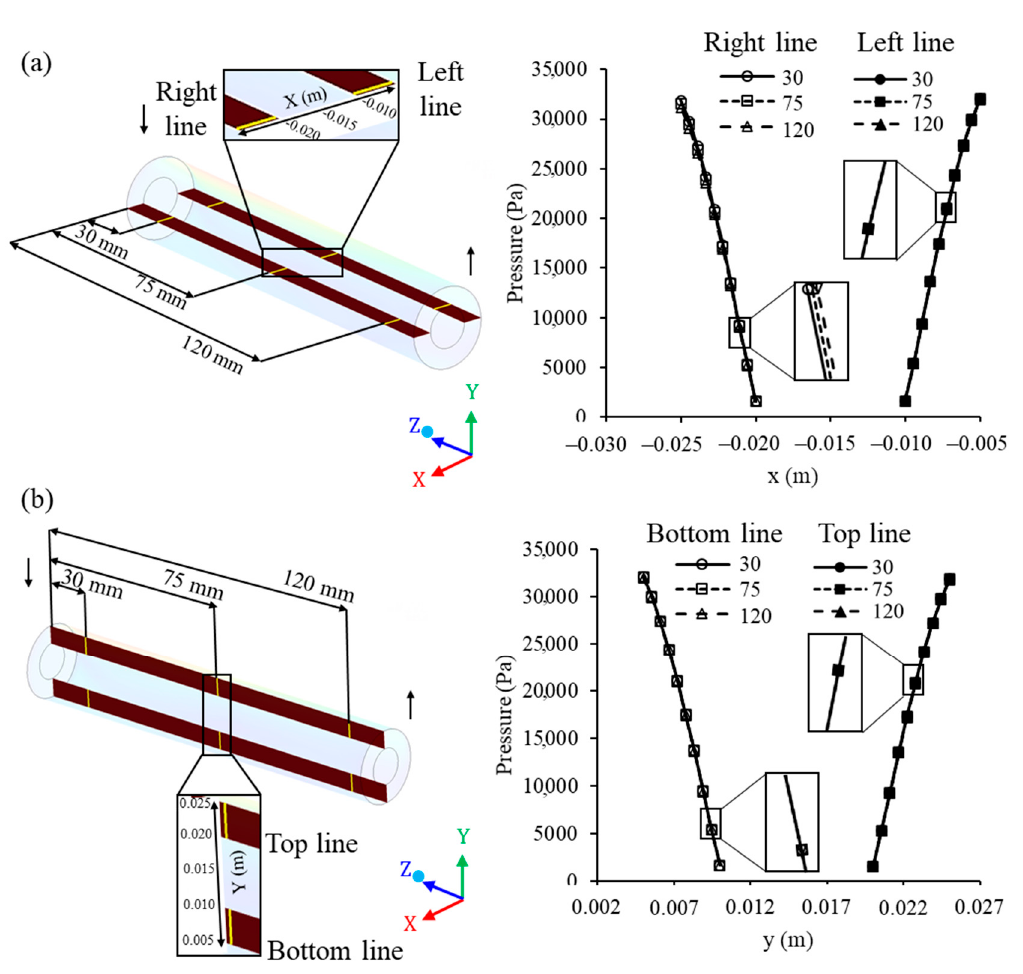
Figure 12. Pressure on the membrane at different ( a ) horizontal and ( b ) vertical points (z = 30, 75, and 120 mm) of the filtration module during the water/oil separation process.